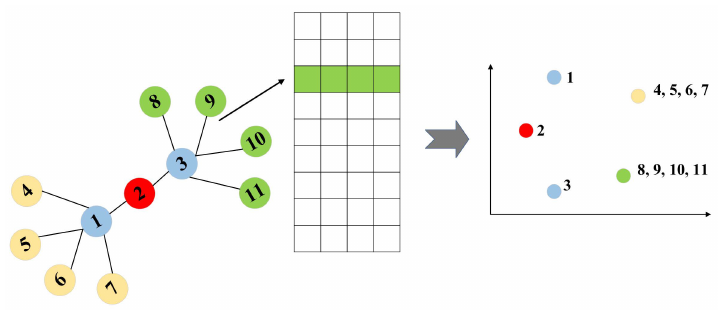
Figure 2. Illustration of graph embedding